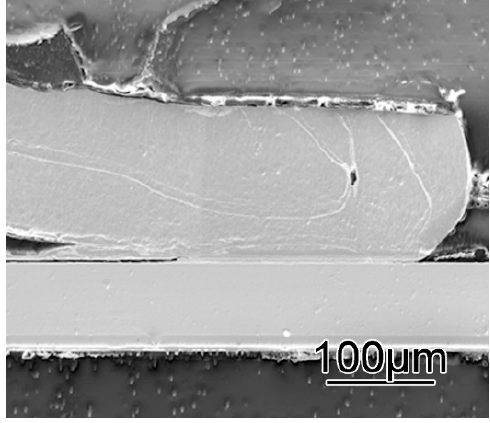
Figure 6. Cross-section of the welded wire cut parallel to the wire direction.